Question: Condense the content of this figure into a single sentence.
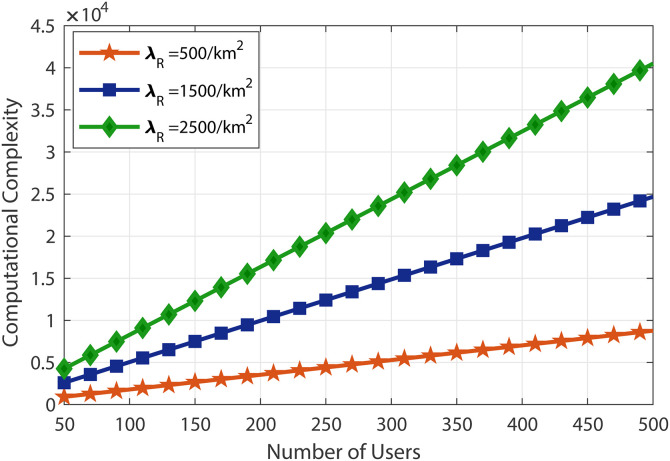
Answer: Computational complexity of the proposed framework with increasing number of users for different RIS densities.